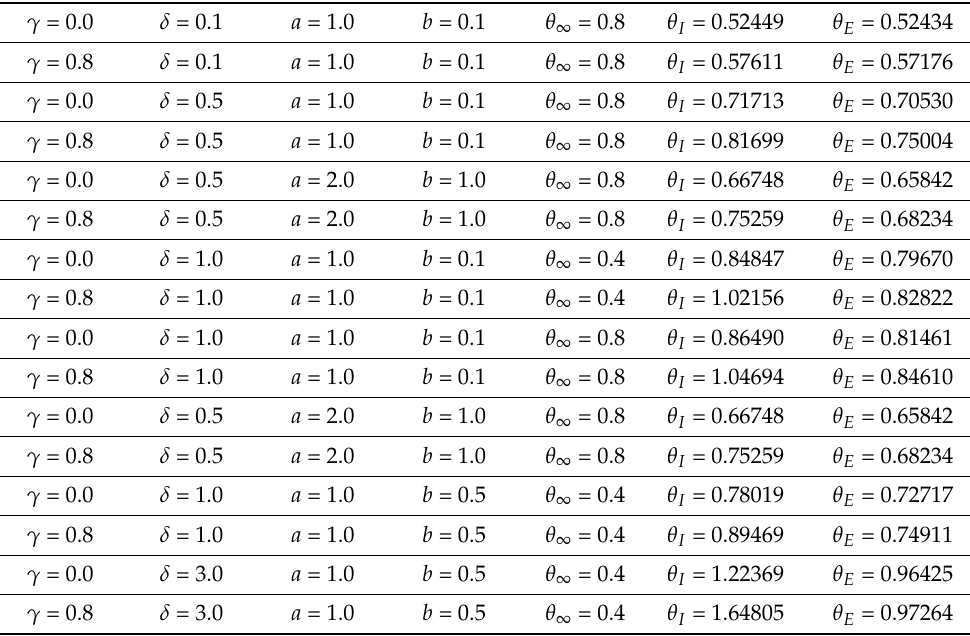
Figure 3. The dimensionless temperature θ as a function of the dimensionless position ξ for δ = 1.0. Table 1. Some values of θ I and θ E obtained for 16 selected